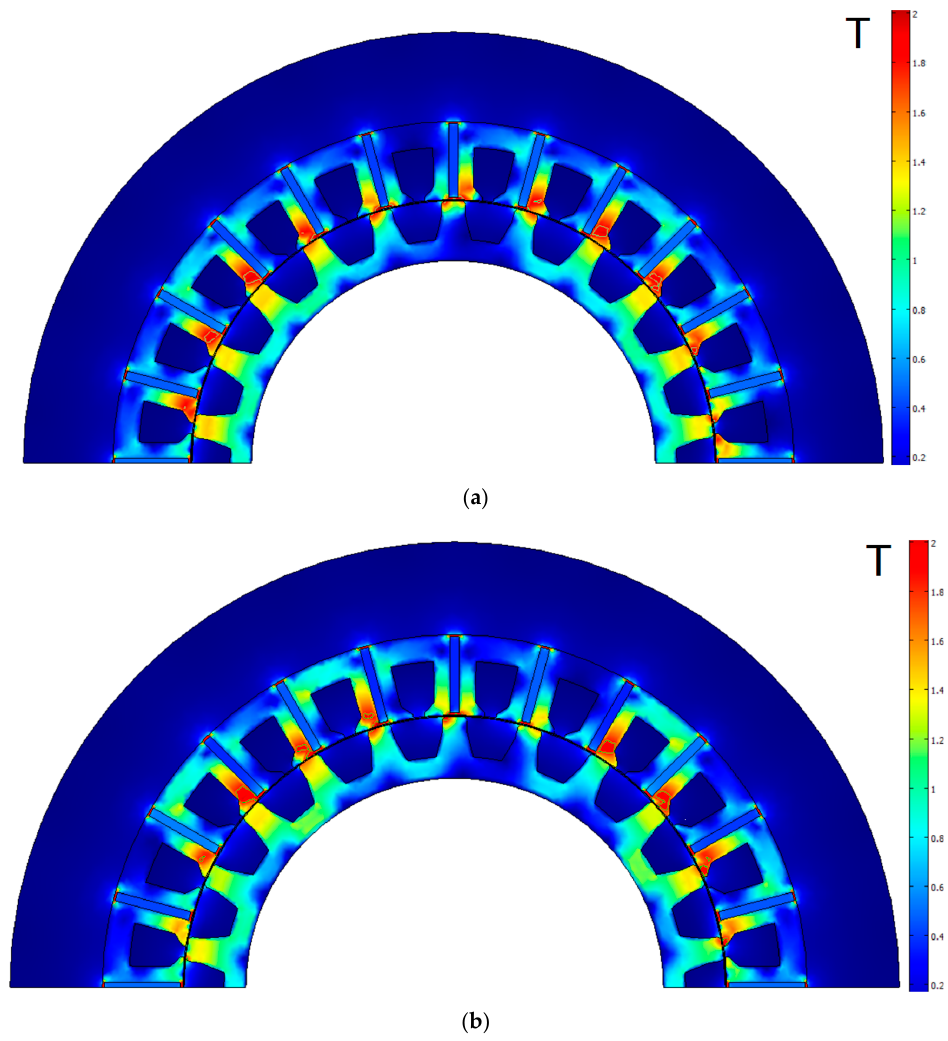
Figure 5. Flux density plot of the initial FSG design: ( a ) underload mode of the two-mode profile; ( b ) rated mode. ( b ) rated